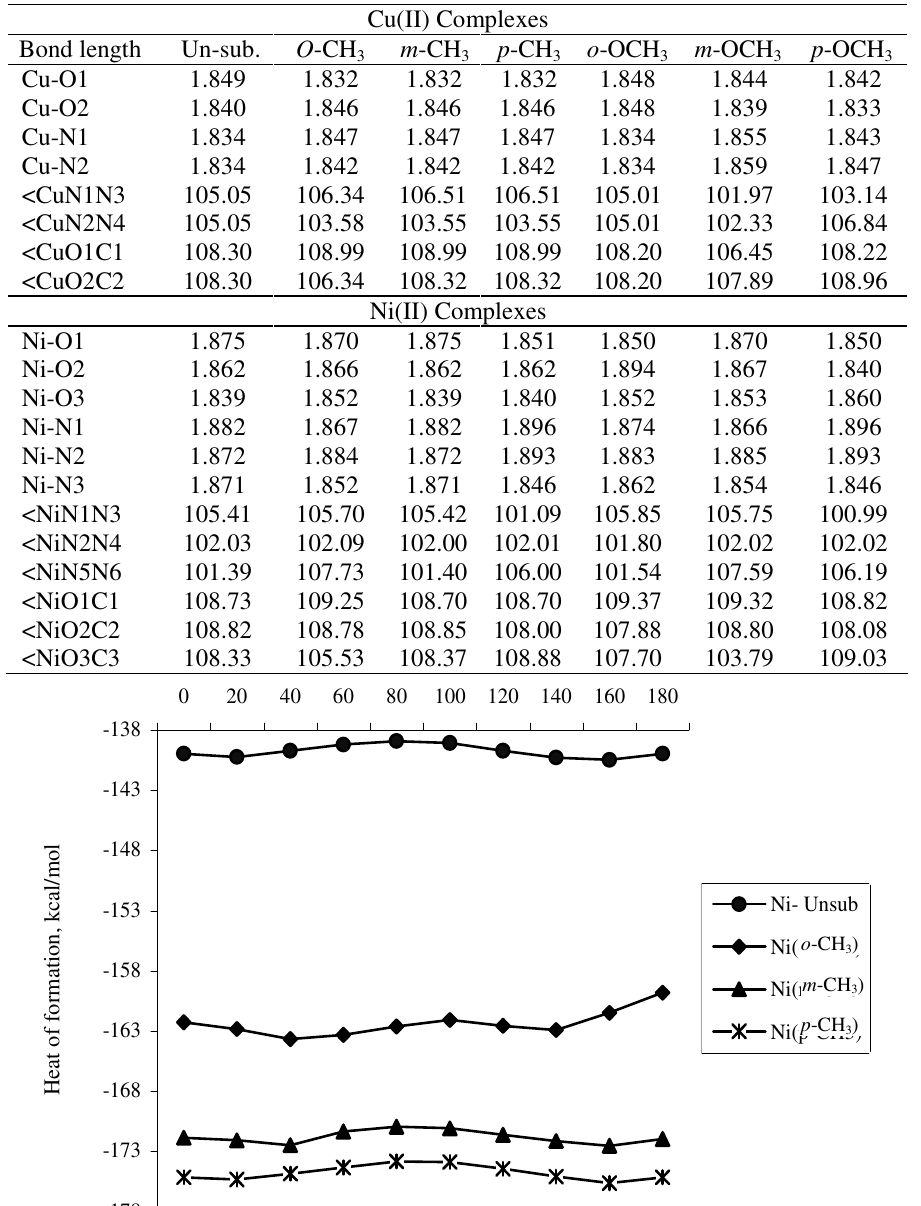
Table 2. Selected bond lengths (Å) and bond angles (°) for Ni(II) and Cu(II) hydrazides derivatives.